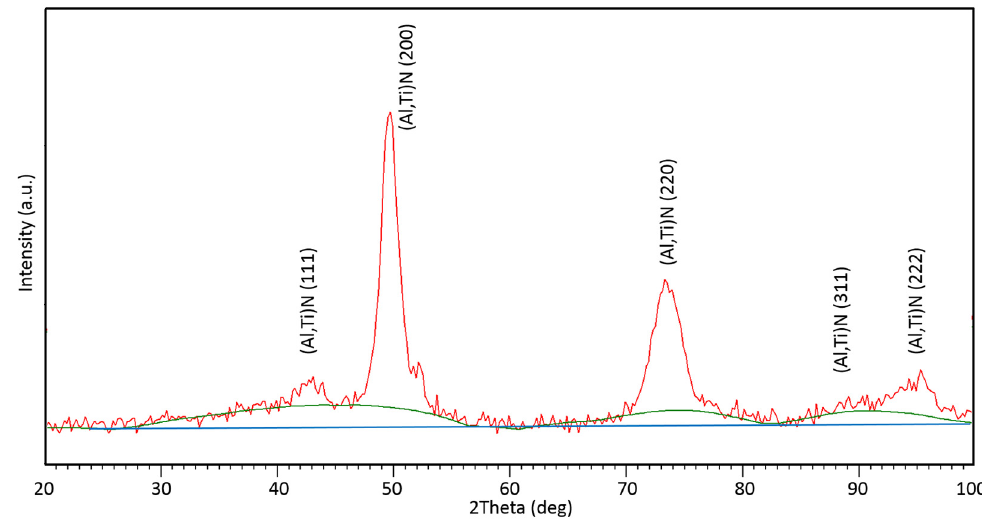
Figure 2. XRD pattern of the coating in as-deposited state (red curve); blue line corresponds to background, and green curve represents the area of the amorphous phase.